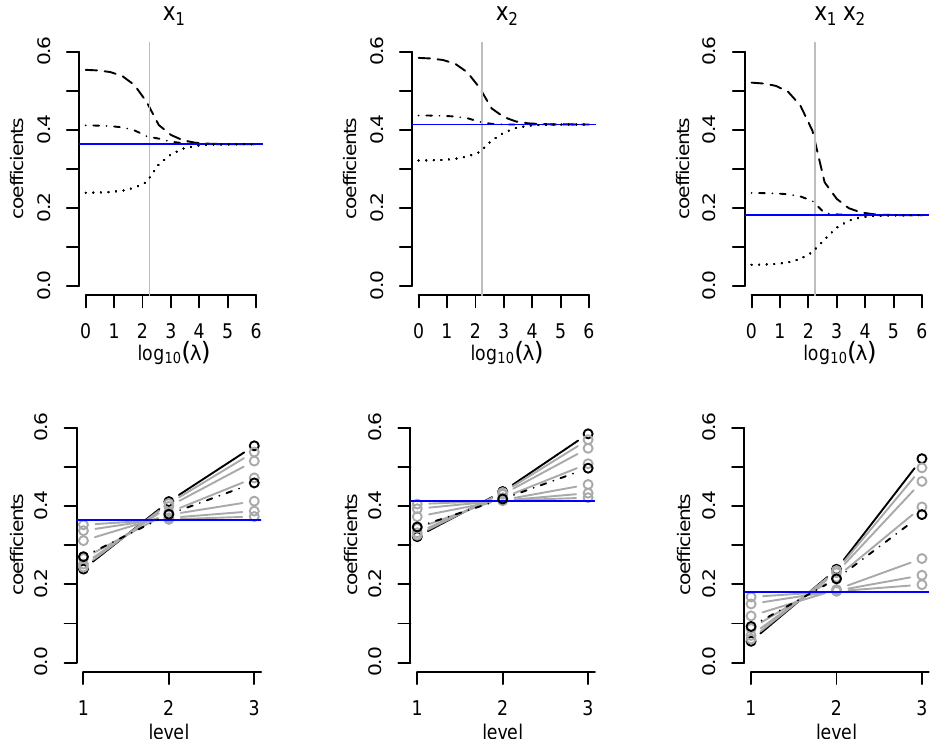
(dashed red) lines on the top and the non-horizontal dashed lines in the down displays of Figure 4 give the resulting set of estimates at which the 5-fold cross-validated test errors (MSPE) were minimal. Unless stated otherwise, this tuning criterion is used throughout this study for SERP-fitted models.